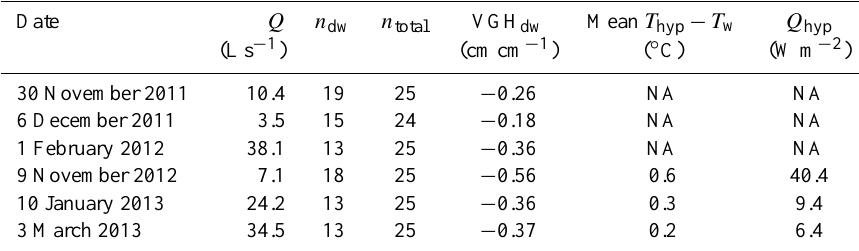
Table 1. Summary of discharge ( Q ), number of piezometers indicating downwelling flow ( n dw ), total number of piezometers measured ( n total ), reach-average vertical hydraulic gradient for n dw (VGH dw ), mean temperature difference between T hyp − T w for upwelling sites, and estimated reach average Q hyp . Note T hyp was not measured for the first three